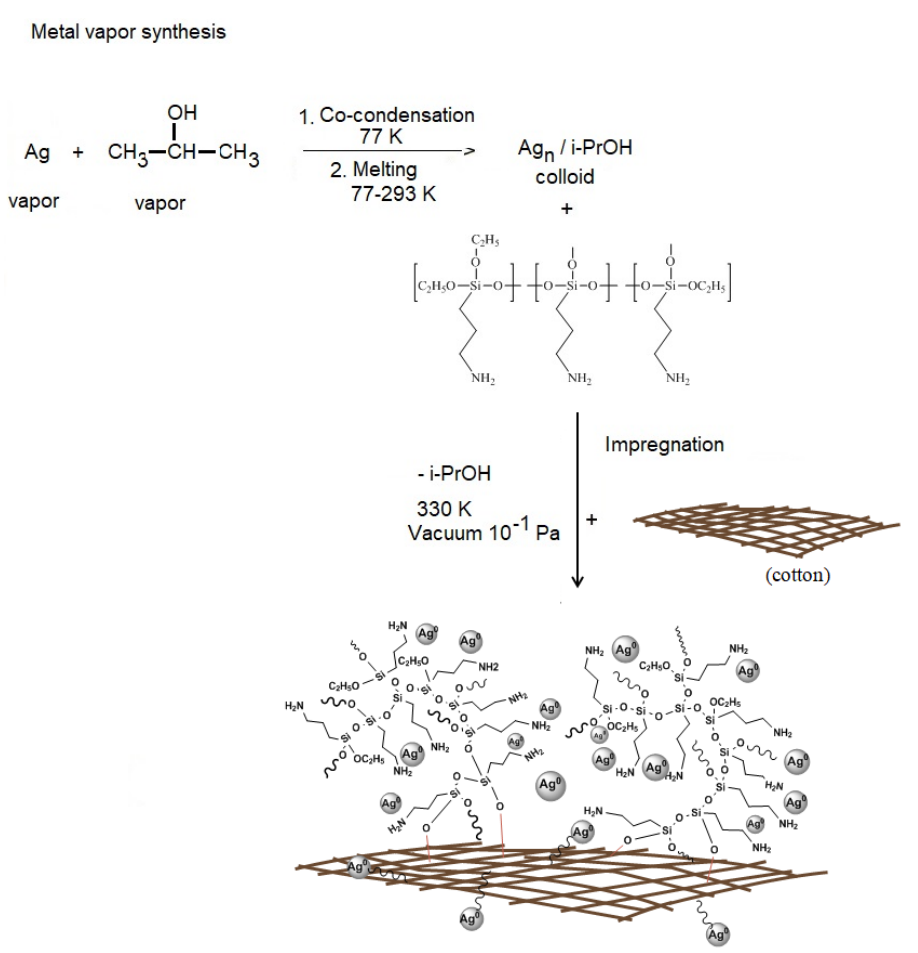
Figure 3. Scheme for obtaining nanocomposite Ag NPs/HBPAPES/cotton.